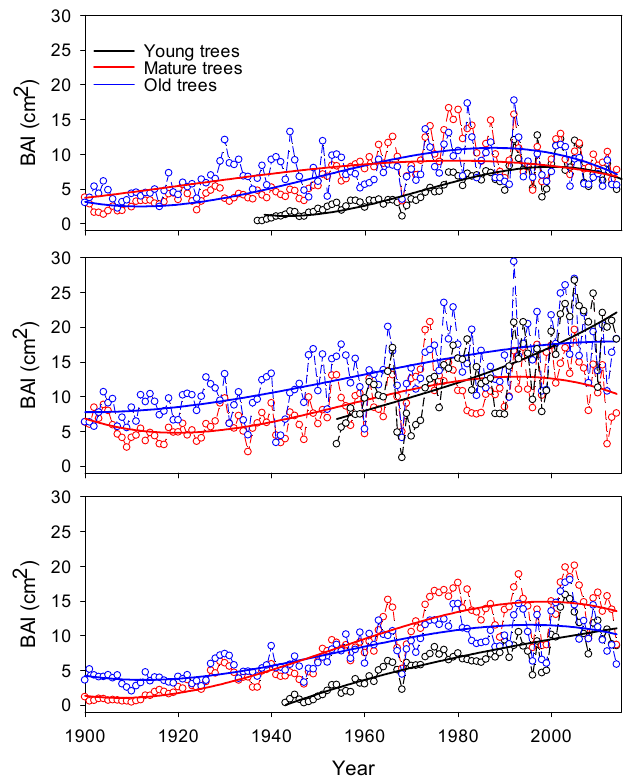
Figure 3. Basal area increment (BAI, cm 2 year − 1 ) chronologies of the three cluster populations and age classes. Trends are enhanced by a cubic polynomial curve ( R 2 > 0.75). ( a ) Coastal, ( b ) Highest, and ( c ) Andes.